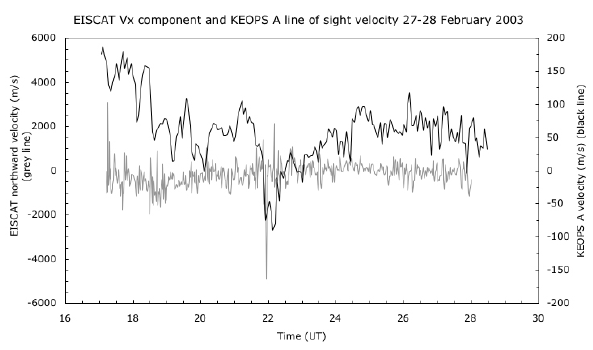
Fig. 3. Comparison of the EISCAT northward component of the field-perpendicular ion velocity (left-hand scale) with the KEOPS FPI line-of-sight thermospheric wind (right-hand scale). The rapid thermospheric response to the ion velocity spike was largely due to a large upwelling caused by Joule heating as shown in Fig.